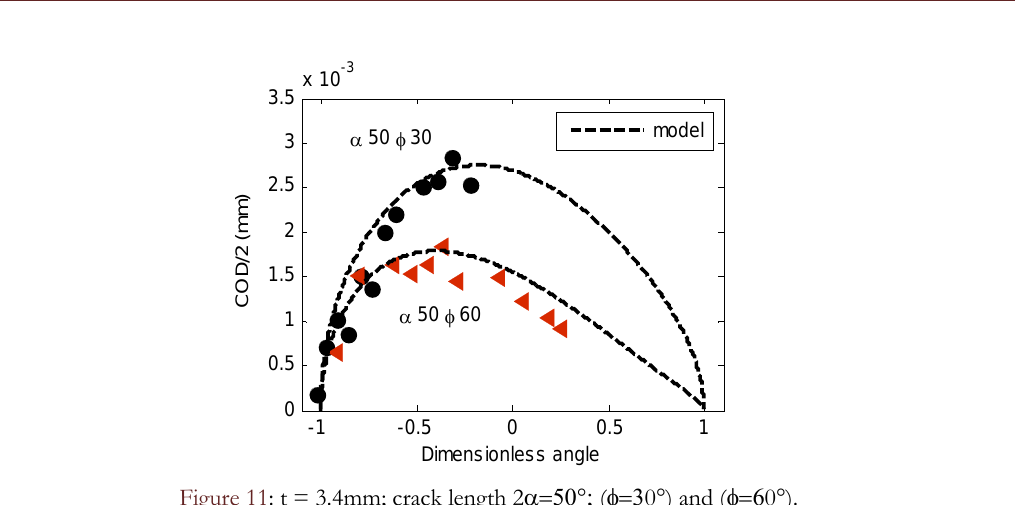
Table 2: Comparison between maximum COD calculated by GE-EPRI and the experimental values.